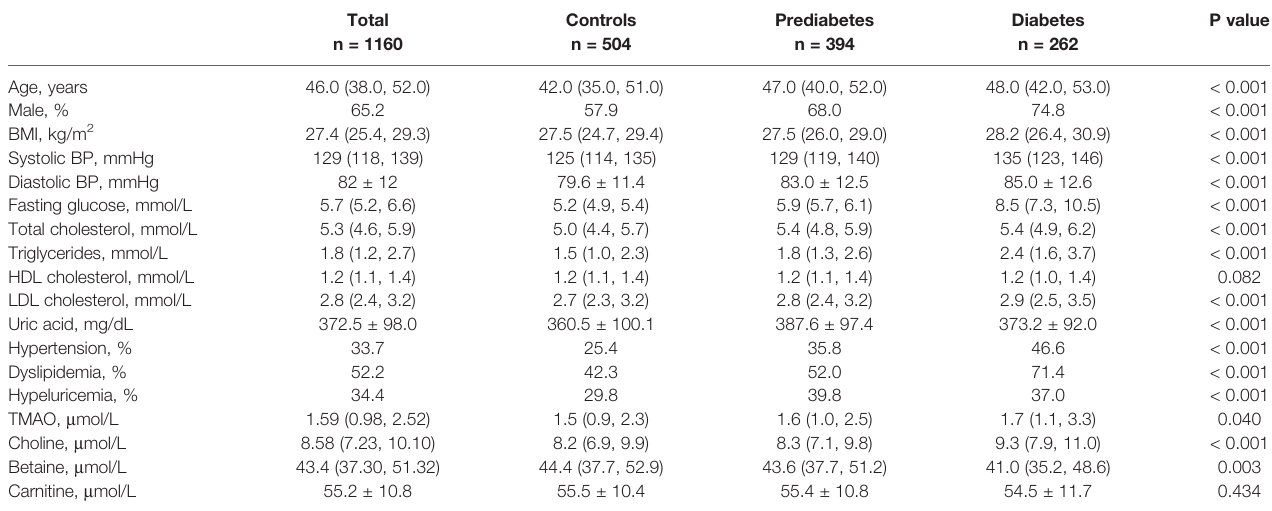
TABLE 1 | Baseline characteristics according to controls, prediabetes and